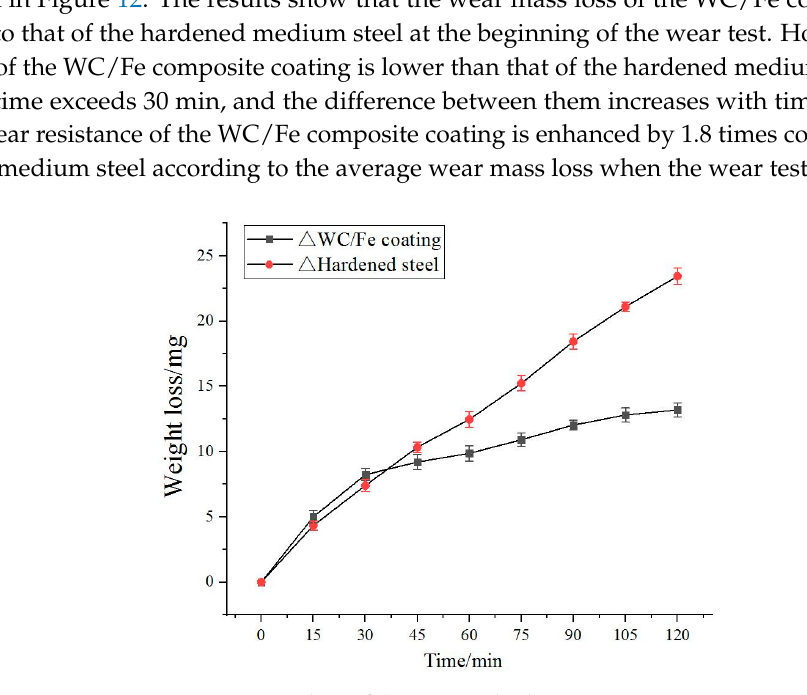
Figure 12. Wear mass loss of the counter bodies against wear test time.